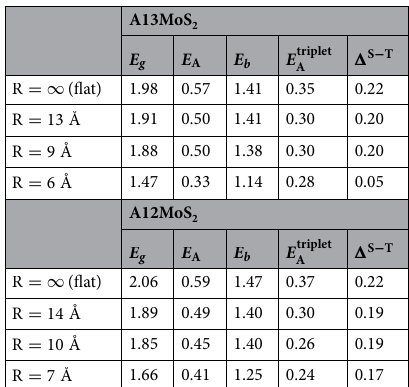
Table 1. The quasiparticle gap E g , the energies of exciton forming the lowest energy peak in the absorption triplet spectra E A (for spin singlet), E A (for spin triplet), the binding energy of this exciton and the spin singlet–triplet split (cid:31) S − T for A12MoS 2 and A13MoS 2 nanoribbons under different bending curvature radii. E g is from GW calculations. E b = E g − E A and (cid:31) S − T = E A − E